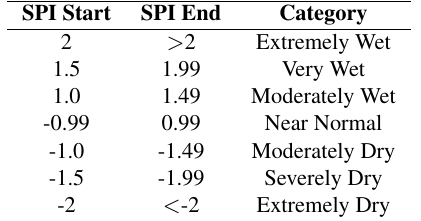
Table 1. Standardised Precipitation Index